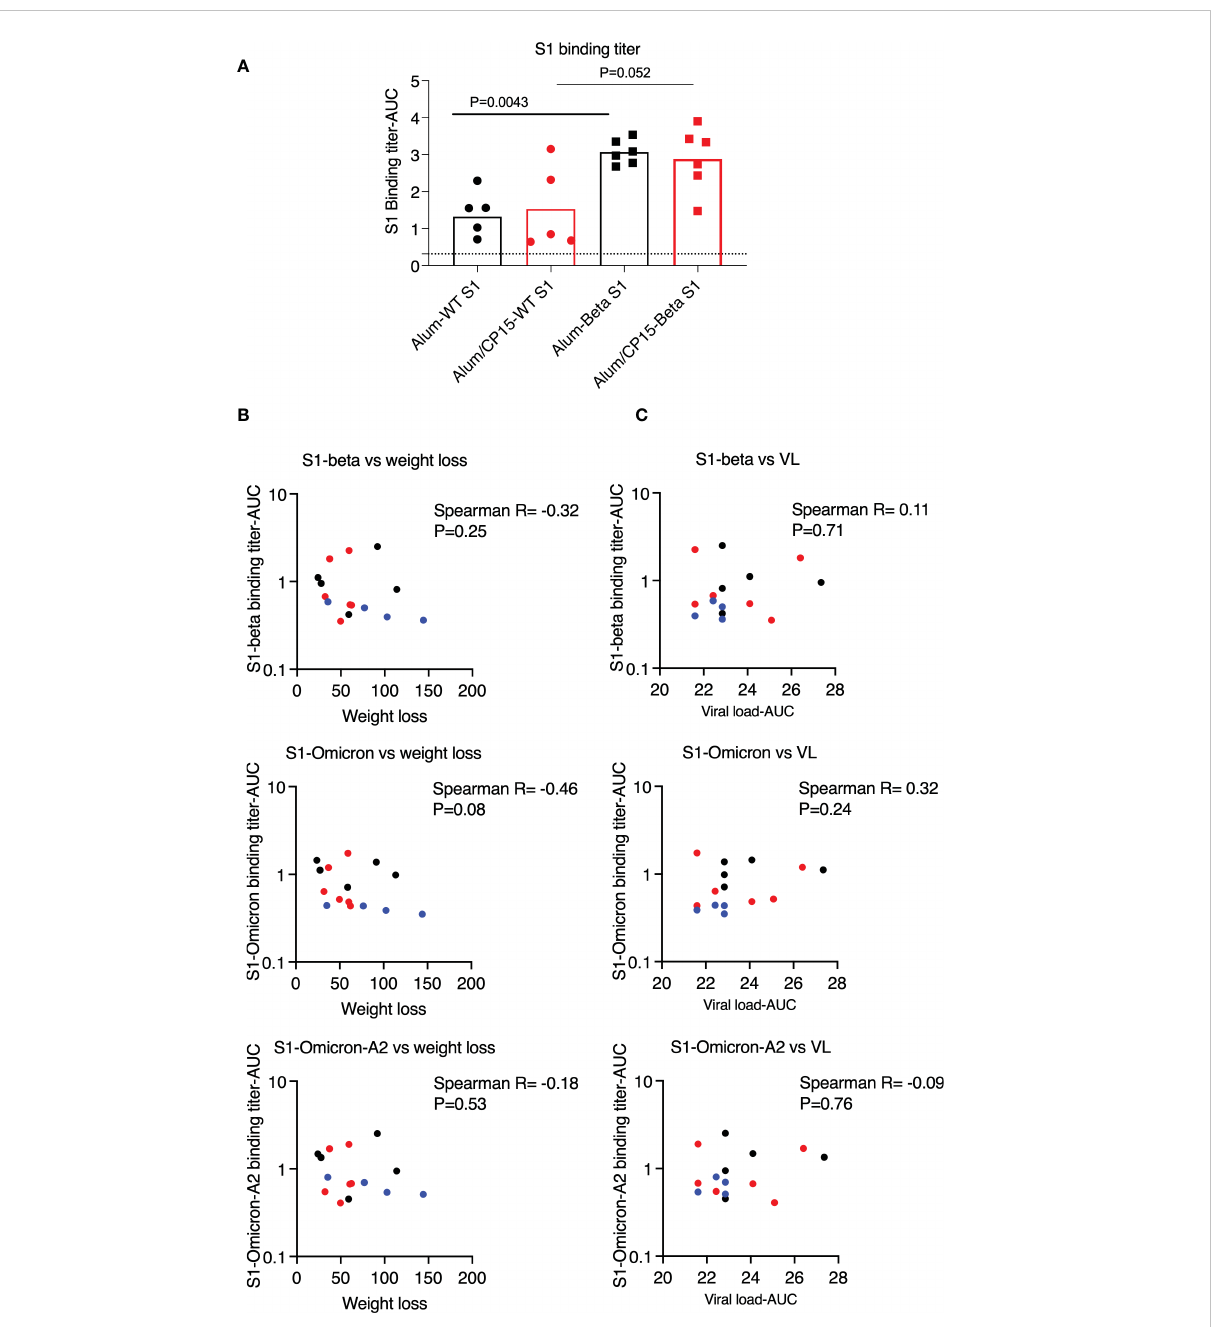
FIGURE 6 Binding antibody titers against S1 variants, which were lower than those of vaccinated with beta variant S1, did not correlate with weight loss or viral loads (VL) in the hamsters after SARS-CoV-2 Washington strain challenge. (A) . To compare the humoral immune responses, we measured the serum binding antibody titers against Wuhan (Wild type, WT) strain from both this cohort, as well as another cohort of hamsters, which were vaccinated with the same regimen as group1 & 2 of this cohort except the S1 protein was substituted by S1 protein from the beta variant. Serum binding antibody titers against S1 (WT) were lower in this cohort, which were vaccinated with S1 from WT, than those of animals vaccinated with the beta variant S1. (B, C) . Binding antibody titers against S1 variants (4 weeks after the second vaccination) did not correlate with weight loss (B) or VL (C) . Spearman analyses were used for the correlations.